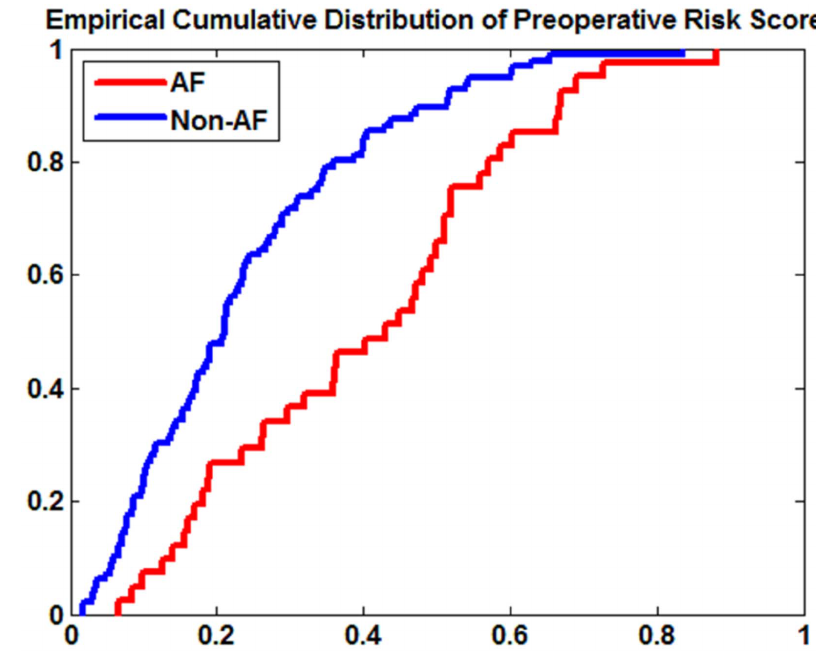
Figure 2. The empirical CDF (cumulative distribution function) of preoperative risk score of AF and Non-AF groups.